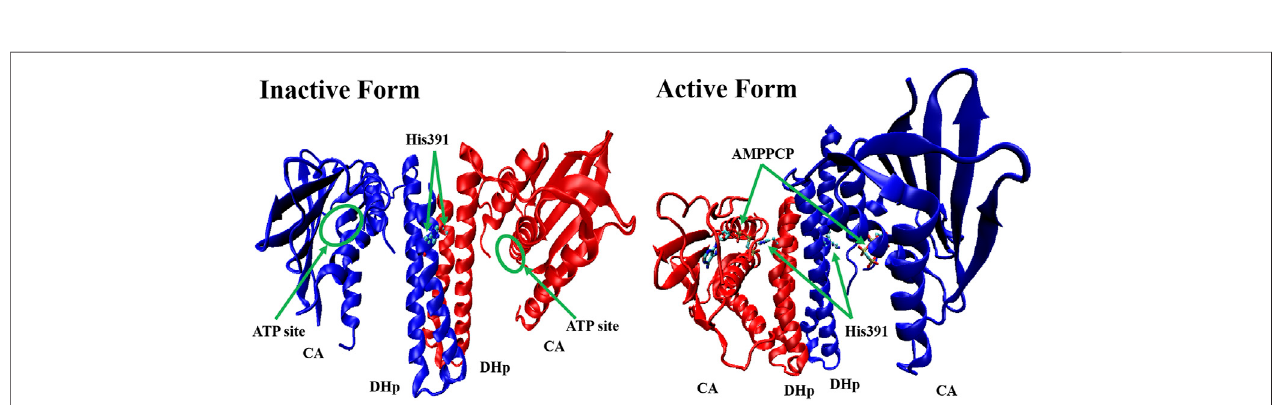
FIGURE 3 | The crystal structure of inactive form (left, PDB: 4U7N) and active form (right, PDB: 5C93) of WalK (Cai et al., 2017). WalK is represented by a cartoon tubemodel,theHis391isrepresentedbyballs-sticksmodel,andAMPPCP(anonhydrolyzableanalogofATP)isrepresentedbysticksmodel,inwhichoxygenatomsare colored in red, nitrogen atoms are colored in blue, carbon atoms are colored in cyan, and phosphate atoms are colored in tan.